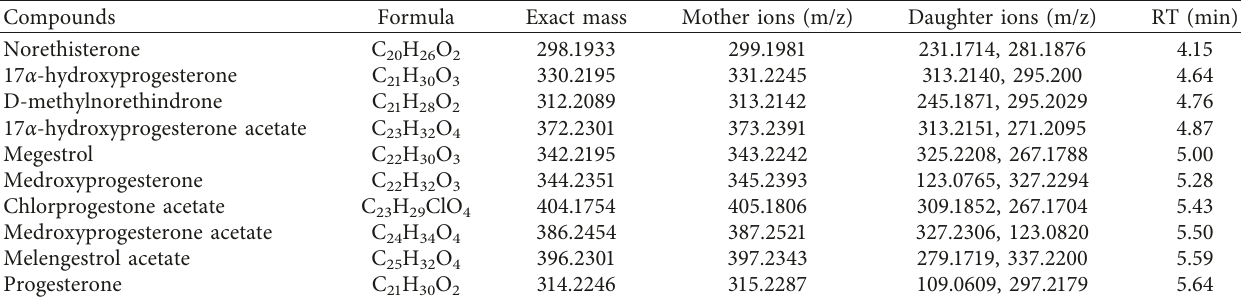
Table 1: TOF parameters of 10